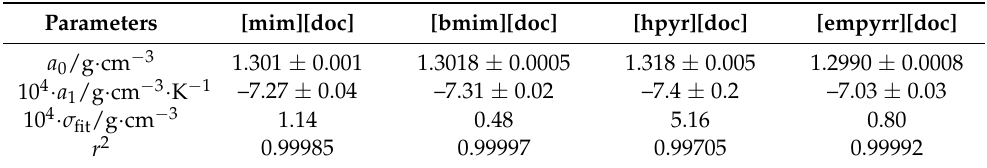
Table 1. Obtained by fitting the experimental data on density with eq. 1 coefficients a 0 and a 1 , the standard deviations of the obtained parameters, the fit standard errors, σ fit , and r 2 of the corresponding